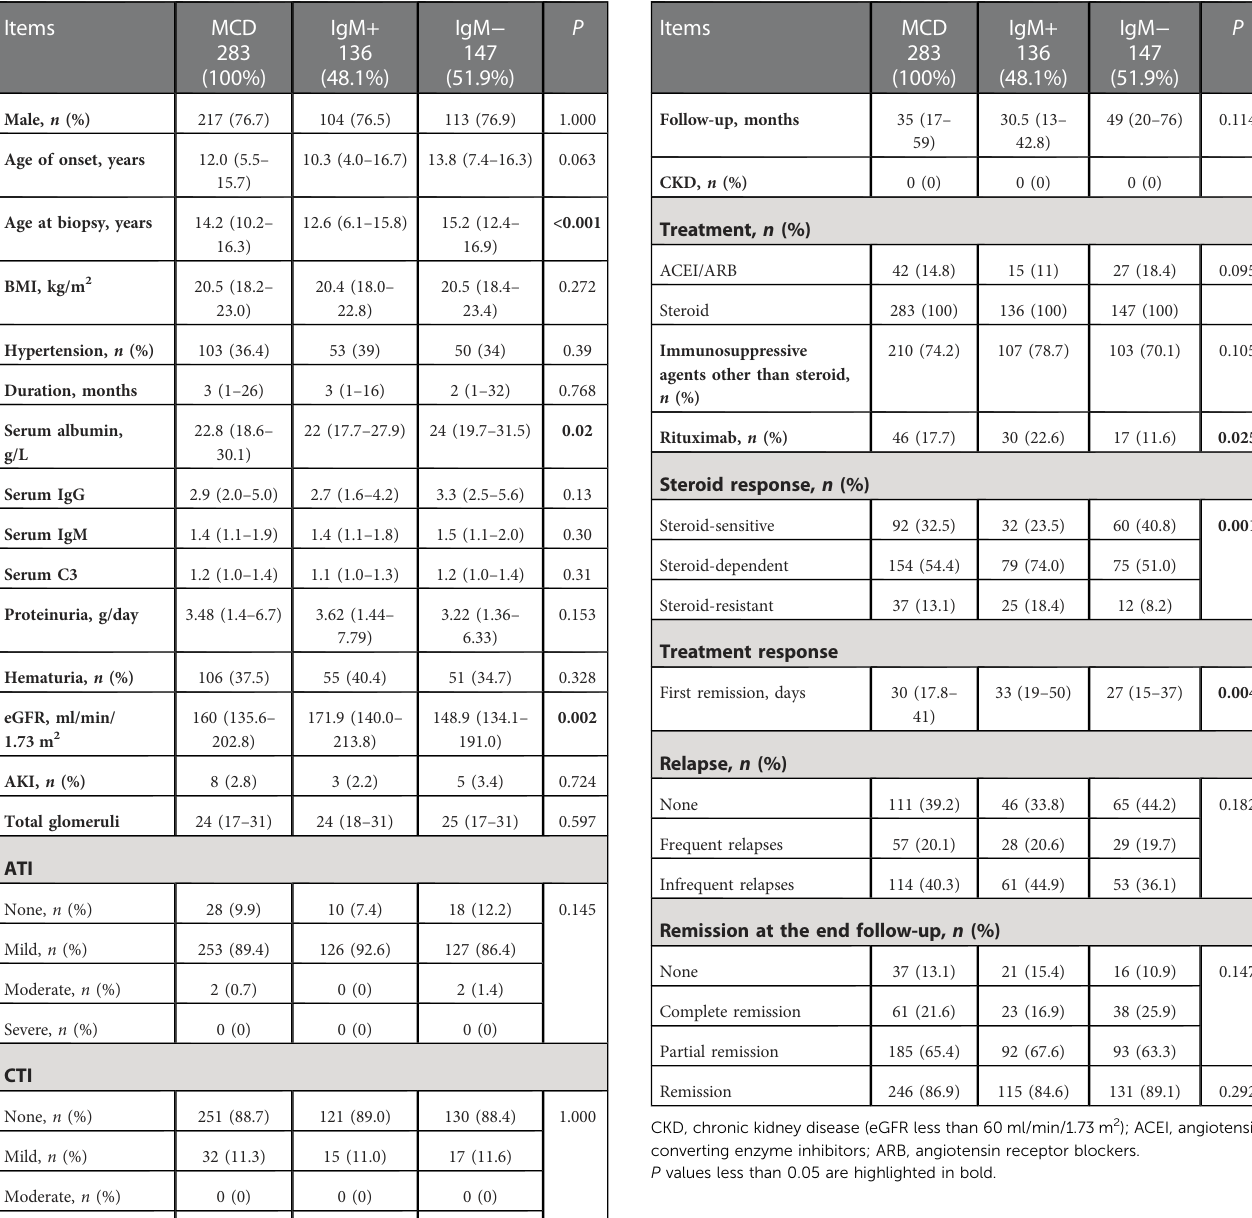
TABLE 1 Demographic characteristics and clinical features at biopsy. TABLE 2 Treatment and outcomes of minimal change disease.